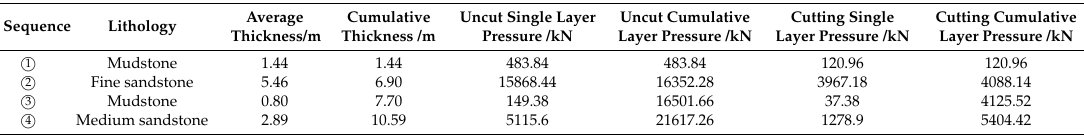
Table 3. Inverse calculation of direct roof